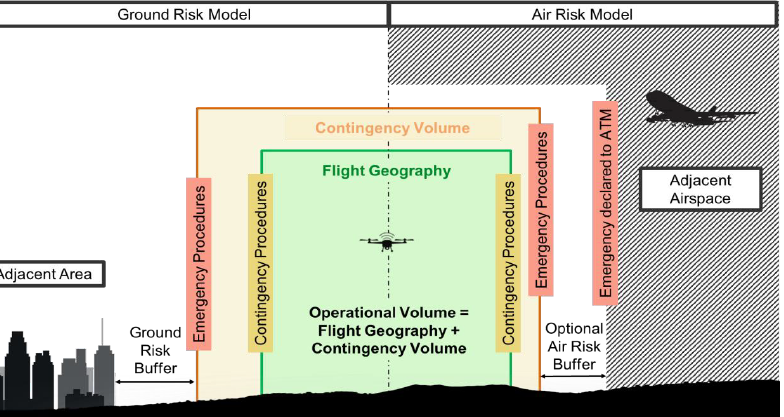
Figure 1. SORA semantic model. Reprinted with permission from [20]. Copyright (2019) JARUS.